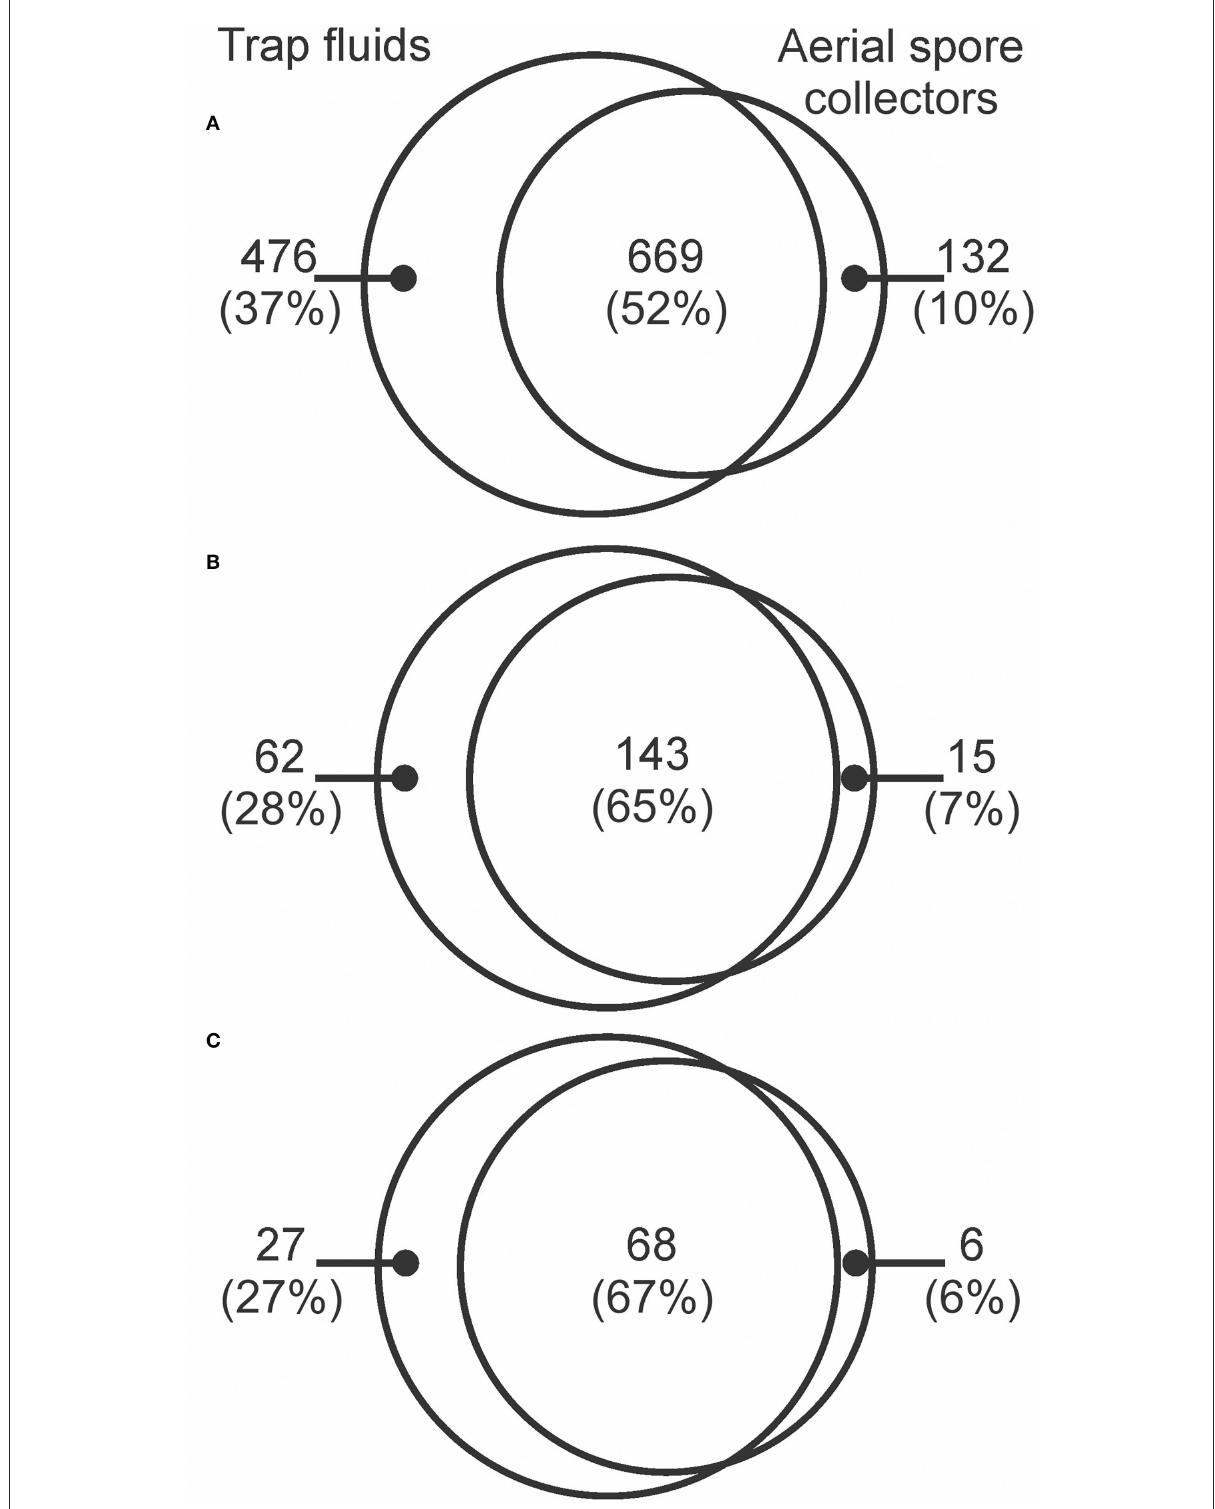
FIGURE1 Venn diagrams showing the numbers of fungal OTUs detected by trap fluids and aerial spore collectors in 2018 at the forest and urban sites in New Brunswick, Nova Scotia, and Ontario (data pooled from all sites) of (A) total fungi; (B) plant pathogens; and (C) forest